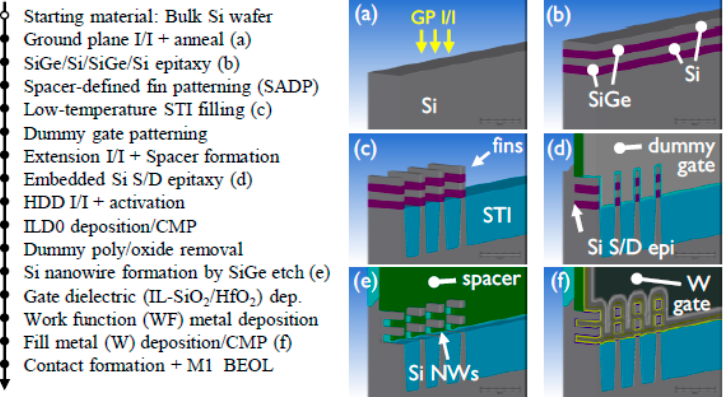
Figure 20. Vertically stacked nanowire process flow including RMG modules. ( a ) Ground plane I/I + anneal; ( b ) SiGe/Si/SiGe/Si epitaxy; ( c ) Low-temperature STI filling; ( d ) Embedded Si S/D epitaxy; ( e ) Si nanowire formation by SiGe etch; ( f ) Fill metal (W) deposition/CMP. Reprinted with permission